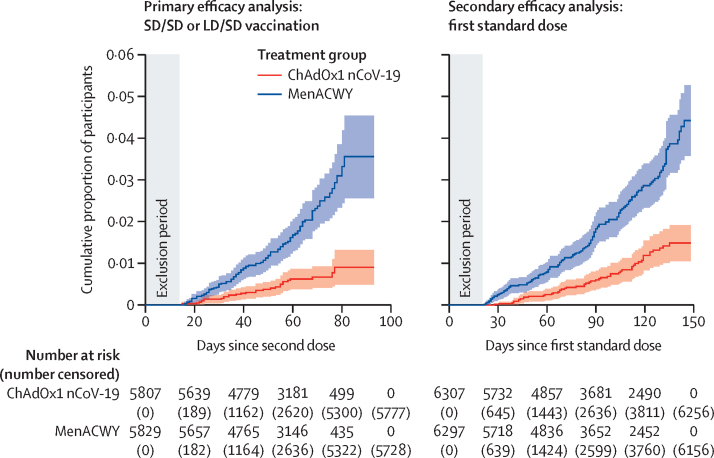
Kaplan-Meier cumulative incidence of primary symptomatic, NAAT-positive COVID-19Cumulative incidence of symptomatic COVID-19 after two doses (left) or after first standard dose in participants receiving only standard-dose vaccines (right). Grey shaded areas show the exclusion period after each dose in which cases were excluded from the analysis. Blue and red shaded areas show 95% CIs. LD/SD=low-dose prime plus standard-dose boost. MenACWY=meningococcal group A, C, W, and Y conjugate vaccine. NAAT=nucleic acid amplification test. SD/SD=two standard-dose vaccines given.